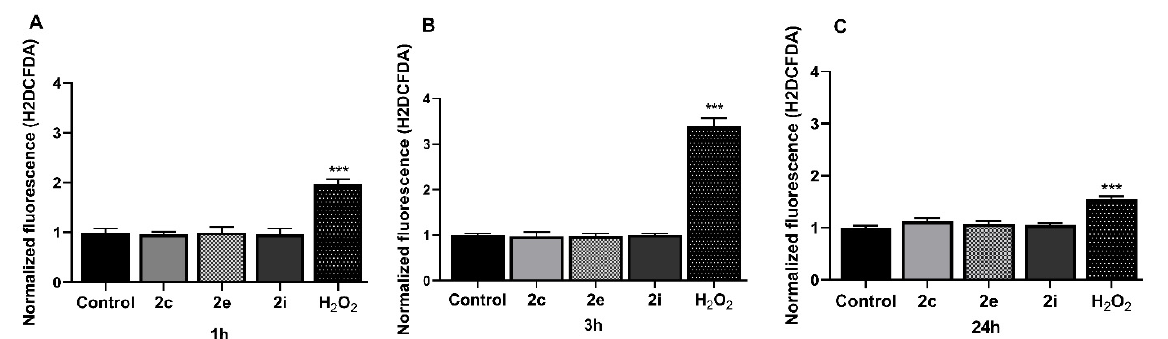
Figure 11. Analysis of reactive oxygen species (ROS) production in trypomastigote forms of T. cruzi treated with 2c , 2e , and 2i for 1 h ( A ), 3 h ( B ), and 24 h ( C ) at IC 50 concentrations of each compound. The H 2 DCFDA fluorescent probe was measured spectrofluorimetrically at 535 nm after excitation at 485 nm. Untreated and H 2 O 2 (20 μ M) ‐ treated parasites were used as negative and positive controls, respectively. Data are expressed as normalized values for the negative (untreated) control. Statistical significance, in relation to the untreated group, was determined using the One ‐ Way ANOVA test, with p < 0.001 (***).